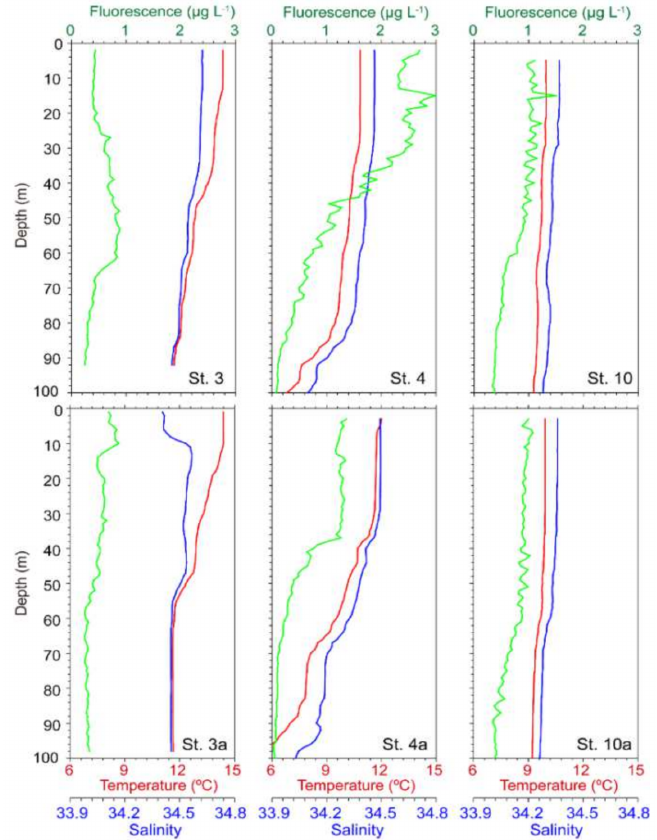
Figure 5. Vertical profiles of water temperature, salinity, and fluorescence during early spring at three stations on 27 February (Stns. 3, 4, and 10) and on 5 March (Stns. 3a, 4a, and 10a). In contrast, during late spring, the vertical profiles of selected offshore and near-island stations had more stratification of temperature, salinity, and fluorescence in the water column (Figure 6). In particular, evidence of water temperature stratification is clearly present in the late spring (Figure 6). An SCM layer was present in the thermocline layer with a strong difference in density. Water stratification was more evident in the vertical profiles on the later sampling dates (Stns. 22a, 26a, and 30a), with temperatures in the upper 10 to 15 m ranging from 15 to 20 ◦ C. The temperature was lower than 10 ◦ C at depths below 50 m at Stns. 22a, 30a, and at depths below 80 m at Stn. 26a. The Chl a levels were much more variable and had sharper increases (up to almost 9 µ g L − 1 at Stn. 22a) during late